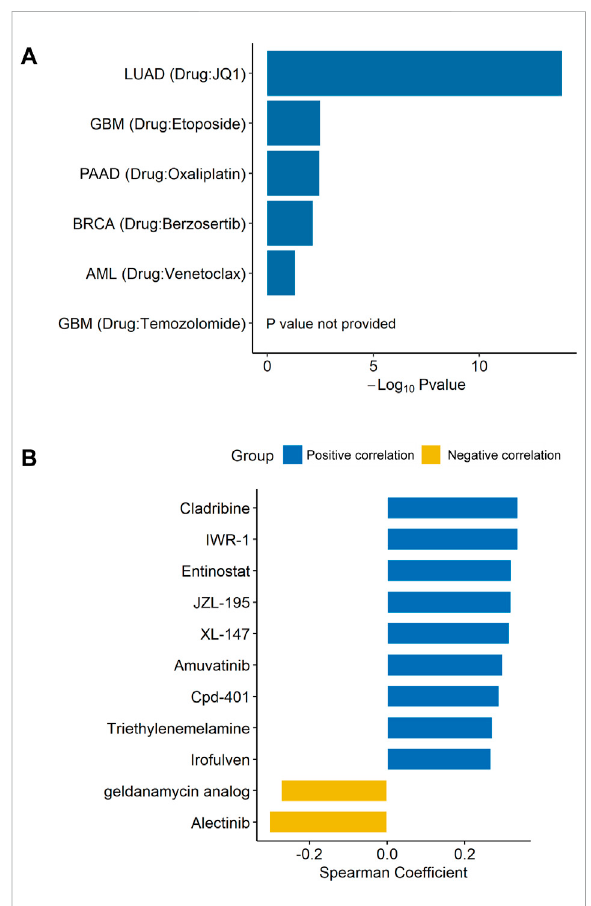
FIGURE 4 DDX56 promotes drug resistance in multiple tumor types. (A) Multiple CRISPR screening studies showing that DDX56 is associated with drug resistance. Y -axis indicates the tumor type and the associated drug. X -axis indicates the logarithm of the negative p -value of DDX56 in each CRISPR screening study. (B) Bar plot showing the Spearman coef fi cients for DDX56 RNA expression and drug IC50. Eleven statistically signi fi cant results were obtained from 450 drugs in the screen. Abbreviations: LUAD: lung adenocarcinoma; GBM: glioblastoma multiforme; PAAD: pancreatic adenocarcinoma; BRCA: breast invasive carcinoma; AML: acute myeloid